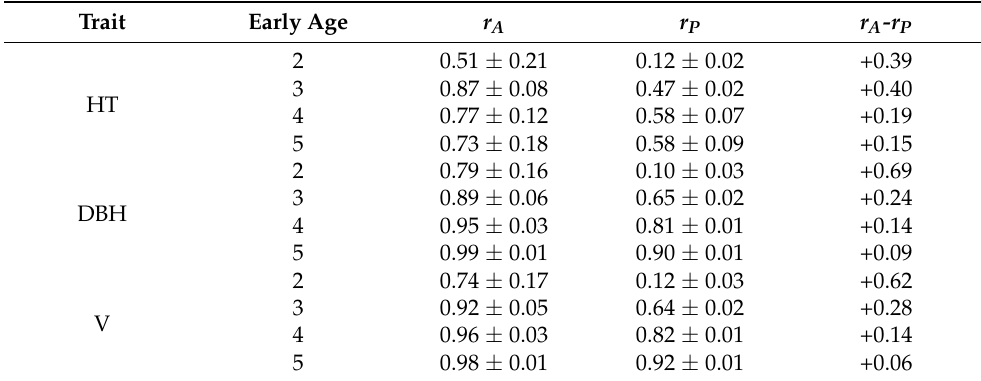
Table 5. Genetic and phenotypic correlations between the early age and the reference age (age 6) for the three growth traits. Trait Early Age r A r P r A -r P